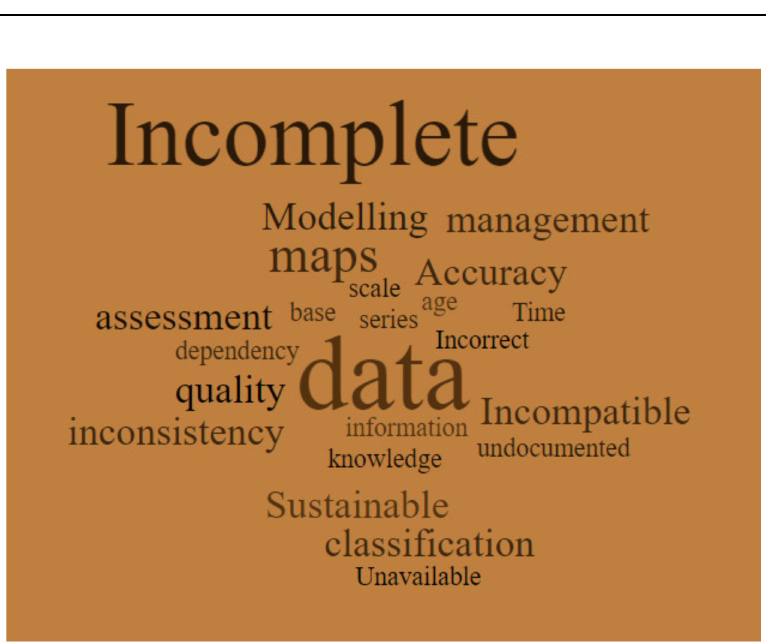
Figure 4. Showing significant challenges associated with Land-use and